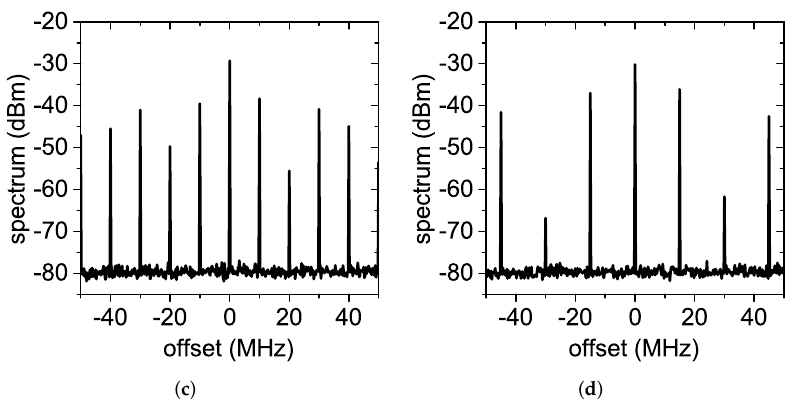
Figure 7. Output spectrum of the modulation-capable frequency doubler with P in = − 10 dBm. ( a ) f m = 500 kHz, ( b ) f m = 1 MHz, ( c ) f m = 10 MHz, and ( d ) f m = 15 MHz.